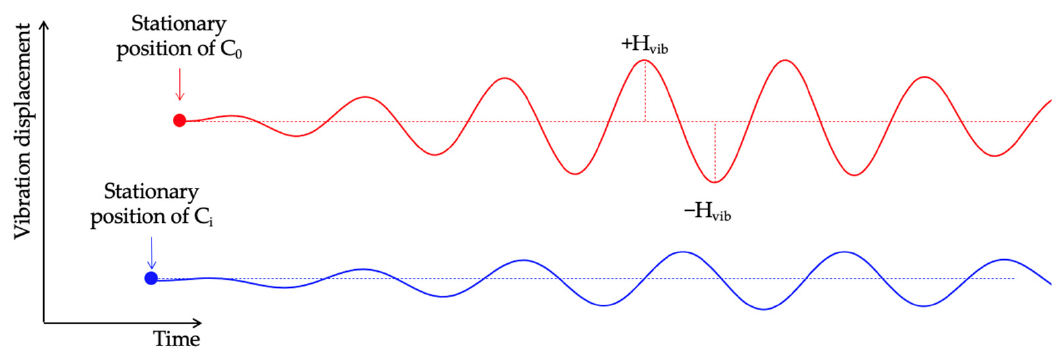
Figure 6. Schematic diagram of strand vibration in the vertical direction.